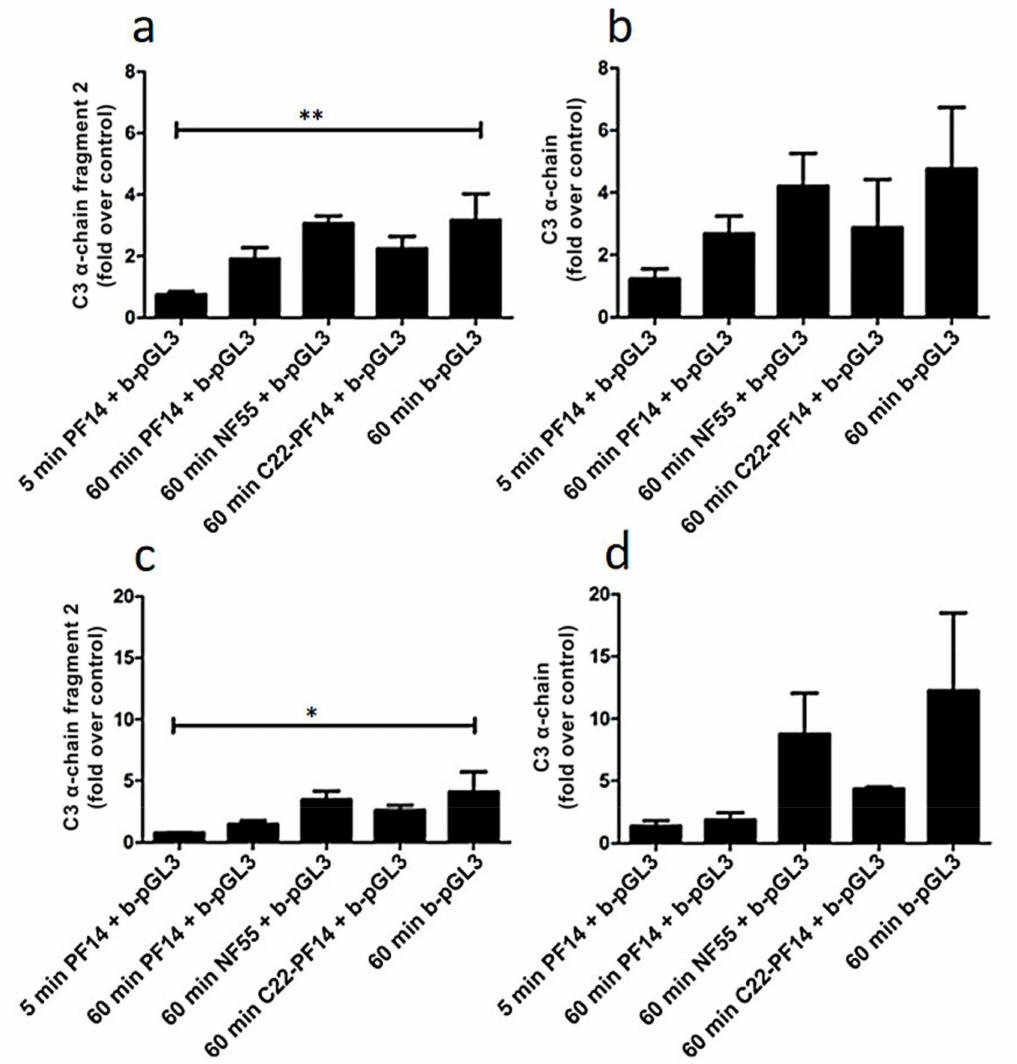
Figure 3. Level of complement component 3 (C3) in protein corona of plasmid DNA and CPP-pDNA nanoparticles. CPP-pGL3 nanoparticles or pGL3 alone were immobilized on streptavidin-superparamagnetic beads, or beads were left untreated (control) before incubation with murine serum ( a , b ) or murine plasma ( c , d ) for 5 or 60 min at room temperature. After pull-down, bound C3 subunits and its fragments were quantified by Western blot. Data represents at least three independent experiments, ± SEM, analysed by one-way ANOVA with Dunnett’s test, * p -Value < 0.05, ** p -Value <